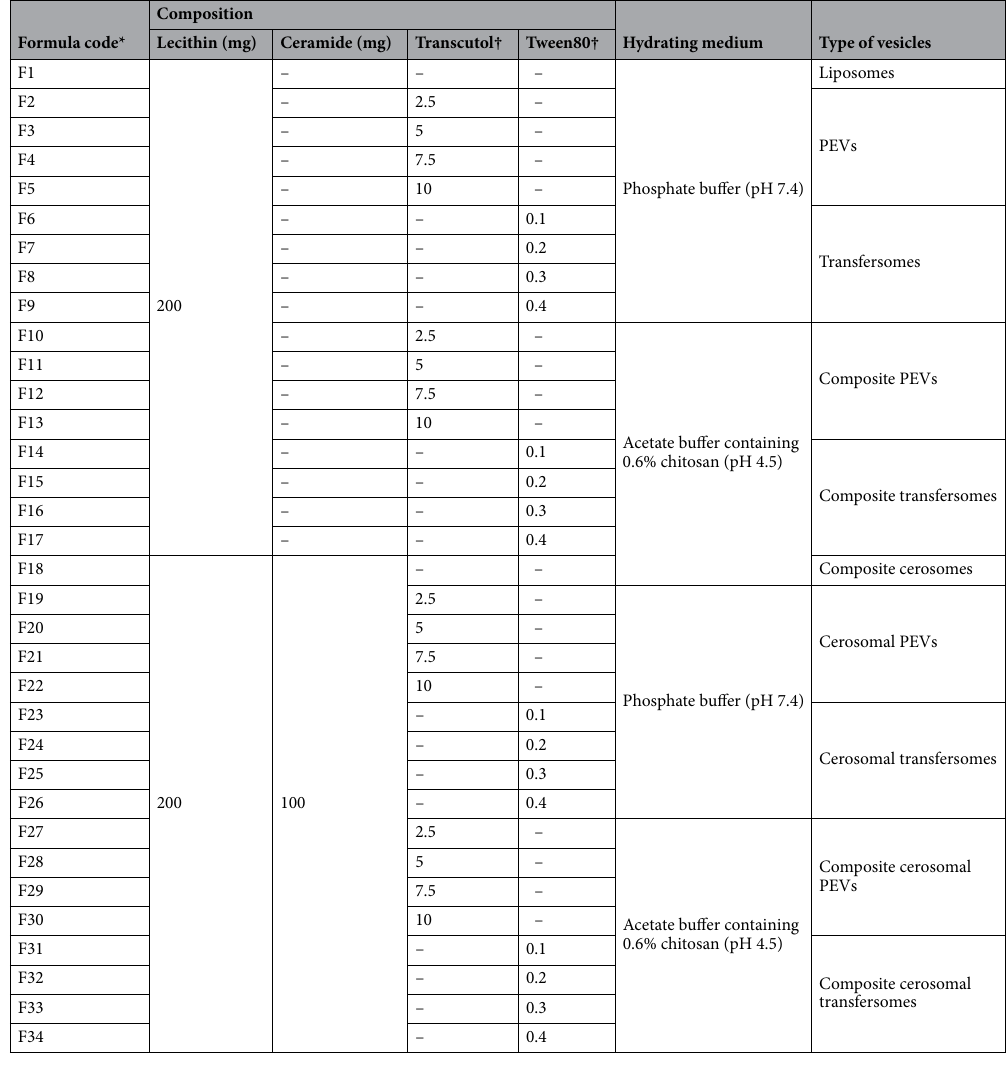
Table 1. Composition of different nobiletin loaded vesicular systems. *All formulations contained 50 mg nobiletin. † Added as %w/v of the total volume of the